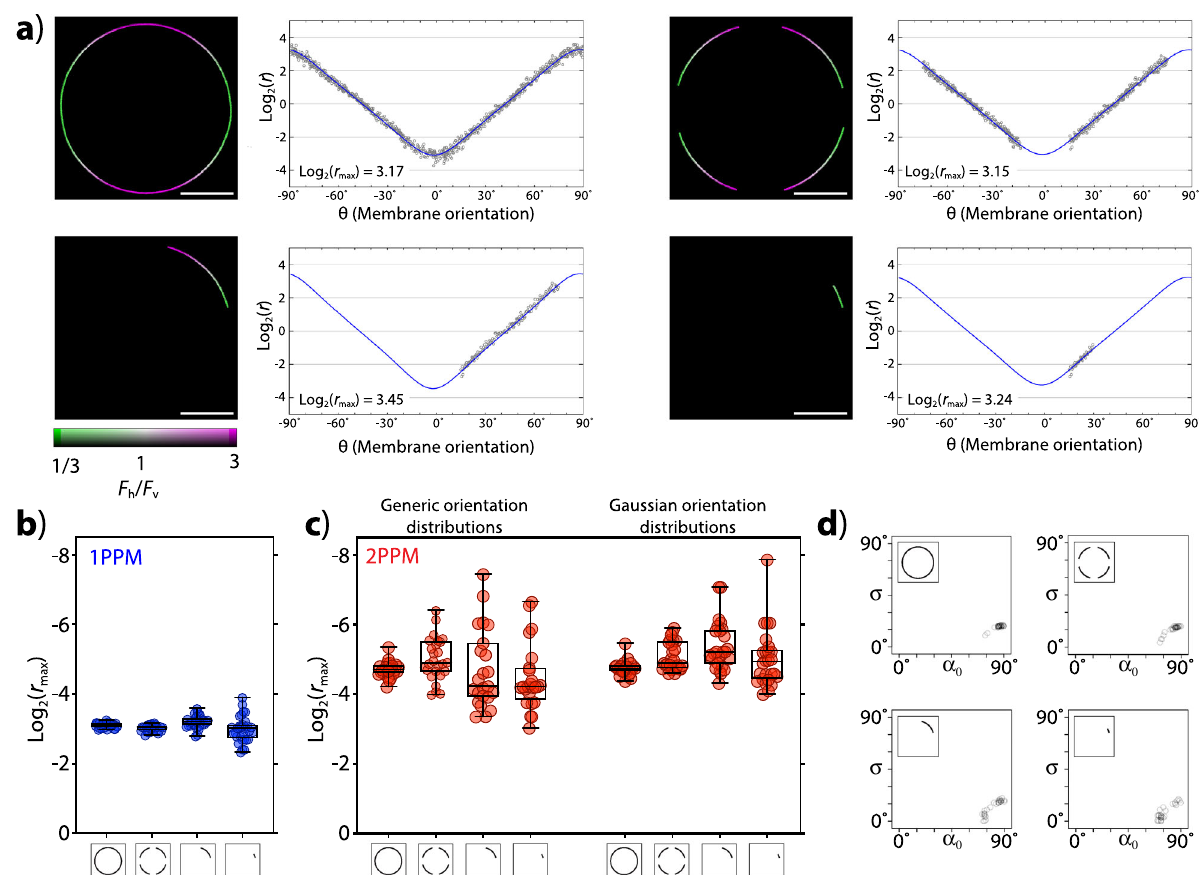
Fig. 4 Obtaining quantitative information on LD from limited data, illustrated on DiI-stained GUVs. a Left panels: 1PPM images of GUVs or sections of GUVs used for analyses, colored according to LD as indicated by the color bar. Scale bars: 10 µ m. Right panels: graphs of the corresponding dichroic ratio data (expressed as log 2 ( r )), as a function of membrane orientation (angle θ ), with the value of log 2 ( r max ) shown. The data fi t used to obtain the value of log 2 ( r max ) is shown in blue. b Values of log 2 ( r max ) derived from 1PPM data obtained from images of full vesicles or their sections (as indicated). Median values, 25 th and 75 th percentiles, and ranges are shown. c Values of log 2 ( r max ) derived from 2PPM data obtained from images of full vesicles or their sections (as indicated). Left side: fi tting with nonrestricted values of B 2P and C 2P . Right side: fi tting using values of B 2P and C 2P consistent with a Gaussian distribution of molecular orientations. Median values, 25 th and 75 th percentiles, and ranges are shown. d Values of α 0 , σ , derived from images of full vesicles or their sections (as indicated by the